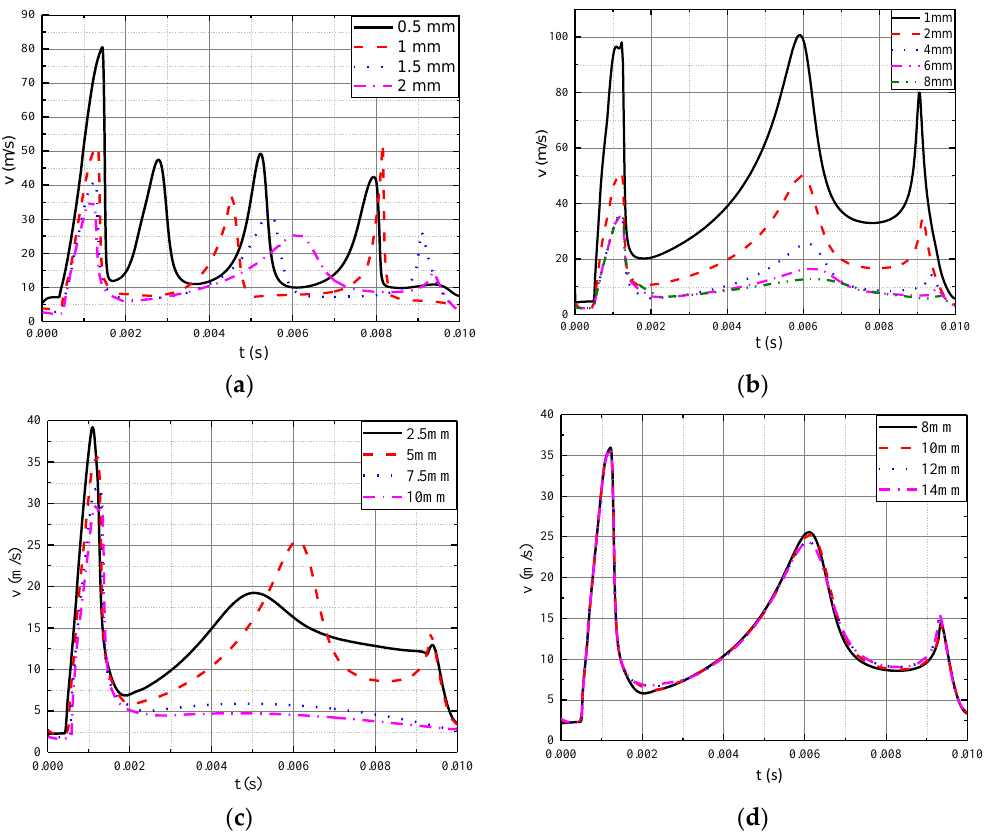
Figure 4. Effect of size parameters of the chamber on the airflow velocity: ( a ) spacing between the spherical electrodes ( d 1 ); ( b ) diameter of the outlet ( d 2 ); ( c ) radius of the spherical electrodes ( R ); ( d ) distance between the electrode and outlet ( d 3 ).